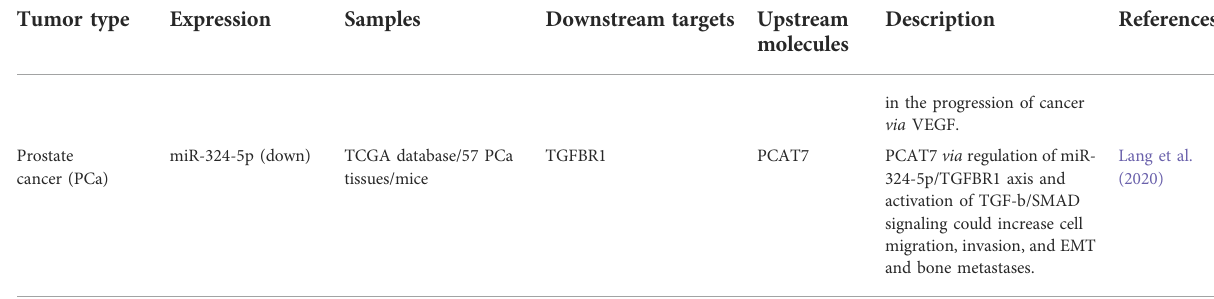
TABLE 2 Prognostic role of miR-324 in cancers (OS, overall survival; DFS, disease free survival). Samples High miR-324-5p and 5p expression levels were correlated with OS. between miR-324-3p and 5p expressions and poor